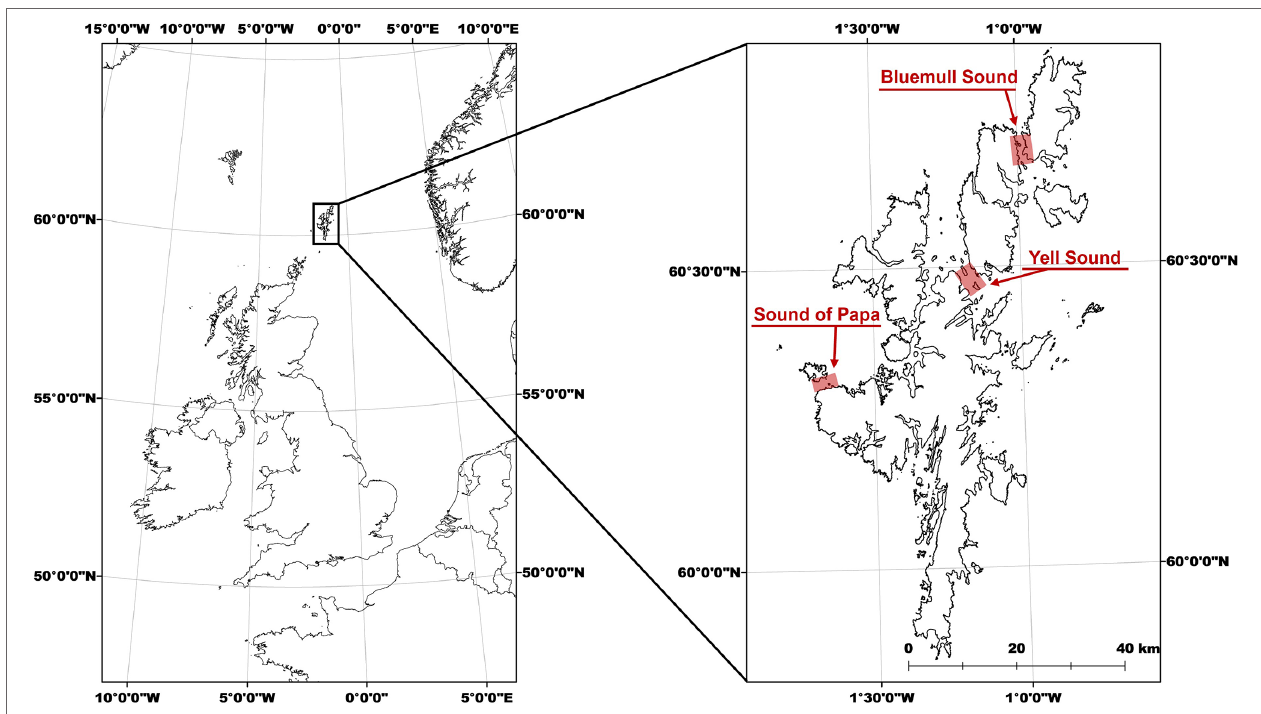
FIGURE 1 | General overview maps of Shetland in UK context (left) and with study sites highlighted (expanded,